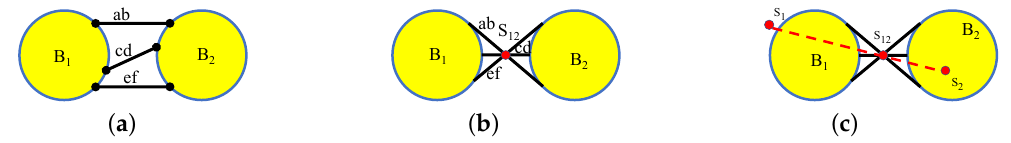
Figure 45. Two plane bodies with 3 bars ( a ). The singular position is where the three bars meet in a point ( b ) which is the relative center of motion. There are many choices for the centers of motion for the bodies, provided that the relative center stays positioned at the projective point of intersection ( c ). (Note here that while the bodies are drawn as circles, they can take any shape and can extend arbitrarily